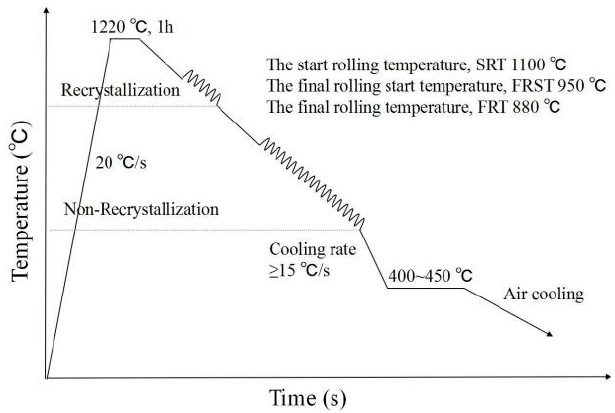
Figure 1. The rolling process flow chart. The 8 mm diameter and 40 mm gauge length rod-shaped tensile specimens were cut from the steel plate along the transverse direction. The tensile tests were conducted at different temperatures, starting from room temperature to 700 ◦ C, and the operation method complied with the Chinese standards GB/T 228.1-2010 and GB/T 228.2-2015. The strain rate was 0.00025 s − 1 . The tensile specimens were heated to the set temperature for holding 15 min before the tensile tests. The tensile tests were conducted on a GNT300 microcomputer-controlled electronic universal testing machine (NCS Testing Technology Co., Ltd., Beijing, China) equipped with an electric furnace. The scanned specimens were cut from the edge of the tensile specimens (undeformed area) and then etched in 4% nitric acid/ethanol solution after water-grinding and polishing. Microstructure examinations were performed using a scanning electron microscope (SEM, FEI Quanta 650, FEI Co., Hillsboro, OR, USA) equipped with an electron backscatter diffraction detector (EBSD, Oxford Nordlys F+, Oxford, UK) at different temperatures. The grain boundaries and interface density of the specimens were collected and analyzed by EBSD. The specimens were electrolytically polished by a 10% perchloric acid/ethanol solution at 12 V for 15 s. The scanning step size was 0.2 µ m, and the area was 100 µ m (rolling direction) × 80 µ m (thickness direction). EBSD information was postprocessed to acquire the relevant data by HKL CHANNEL 5 software (Oxford Instruments Co., Oxford, UK) The nanoprecipitates in the specimens were observed at different temperatures using carbon film replication technology. The polished specimens were deeply corroded in 4% nitric acid/ethanol solution until the surface was black. A 10 µ m-thick carbon film was sprayed on the specimen’s surface, scribed into 2 × 2 mm squares with a razor blade, and soaked in 4% nitric acid/ethanol solution to shed carbon film. Then, it was salvaged with a larger copper mesh, cleaned in ethanol, and then put into distilled water to force the curled carbon film to unfold into squares due to the surface tension of water. It was then salvaged with a 200-purpose copper sheet with a diameter of 3 mm and dried with filter paper to observe the precipitation phases attached to the carbon film using transmission electron microscopy (TEM, FEI Tecnai G20, Hillsboro, OR, USA). The mass fraction of carbonitrides and the nanoprecipitates’ particle diameter distri- bution of specimens obtained at different temperatures was quantitatively analyzed by physical and chemical phase analyses. The experimental steels were dissolved in an “AA solution” (10% (V/V) acetylacetone methanol + 10 g/L lithium chloride solution).